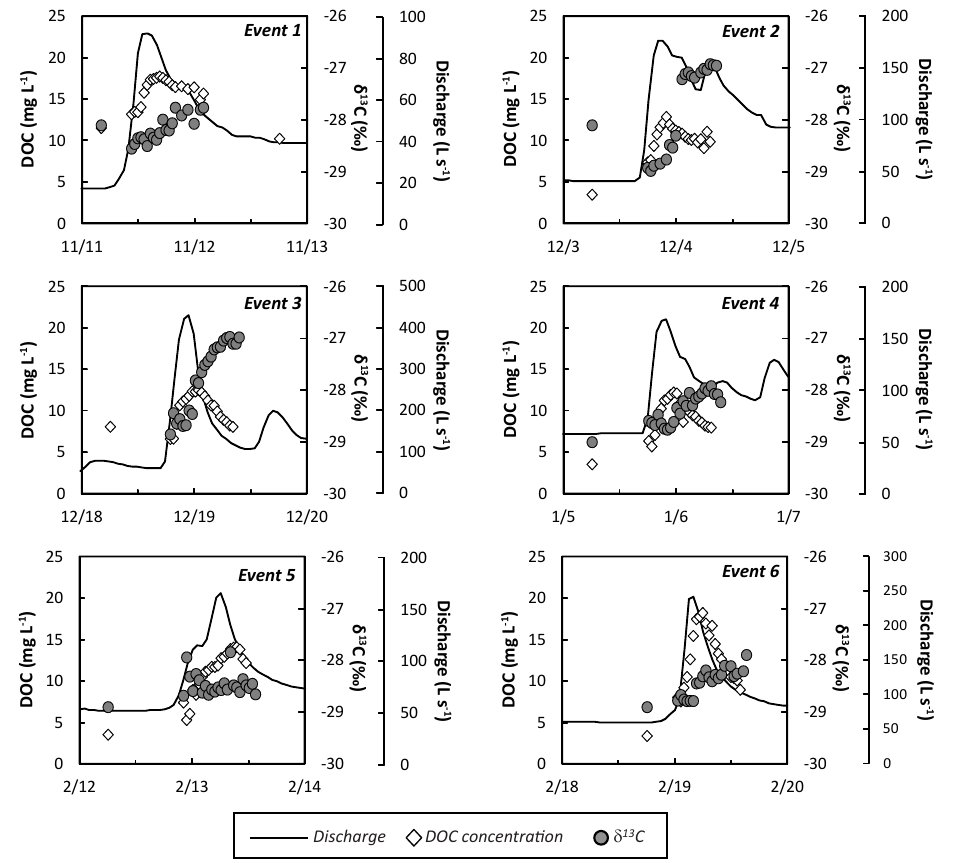
Figure 5. Changes in stream DOC concentrations, stream δ 13 C DOC values and stream discharge during the six investigated storm